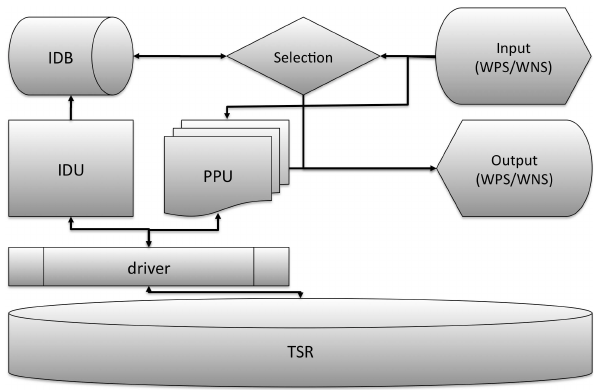
Fig. 6. System architecture of the simulation system: input and out- put modules utilize the web processing service (WPS) and web no- tification service (WNS). The selection unit implements the multi- sensor selection mechanism, comparing measurements with in- dexed scenario data in the index data base (IDB), which in turn is filled by the index data base updater (IDU). IDU and post- processing unit (PPU) access data in the tsunami scenario repository (TSR) through a